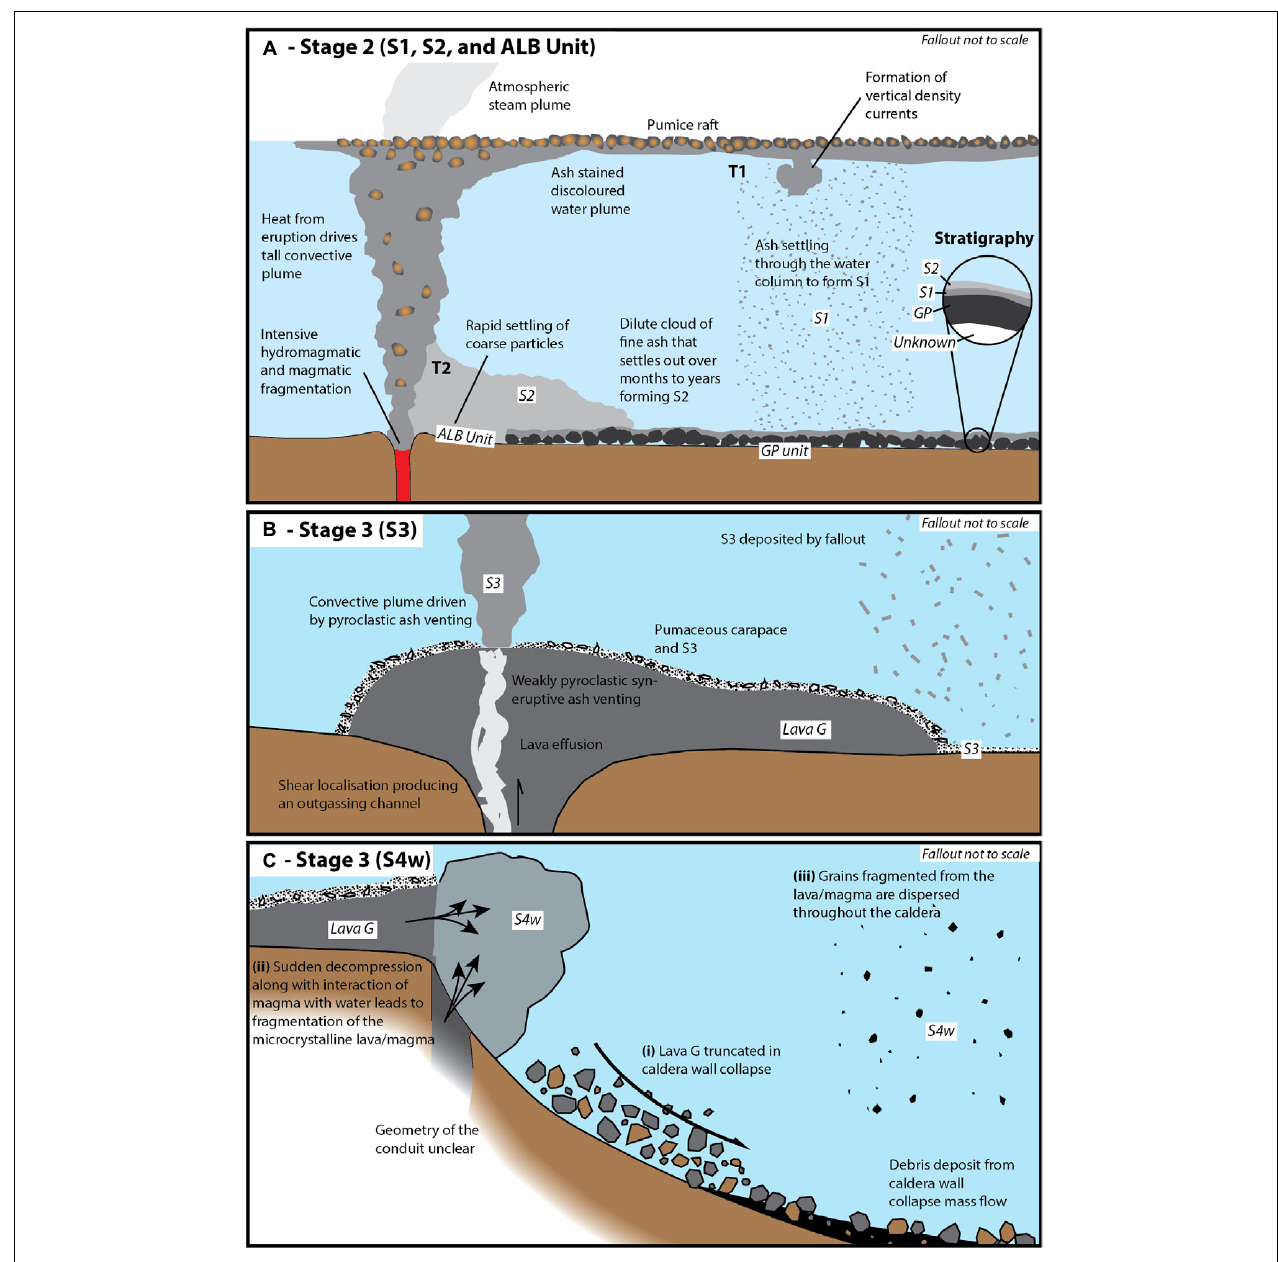
FIGURE 11 | Conceptual model for generation of the various subunits of the seafloor AL unit at Havre. (a) Subunits 1 and 2 are inferred to have been formed from the same eruption [at time 1 (T1) and time 2 (T2), respectively], along with the ALB unit and pumice raft. Energetic wet and dry fragmentation of a highly undercooled, ascending, vesiculating magma generated abundant fine particles that were dispersed in an overlying convective column, fallout from which formed S1. Partial or whole-scale collapse of the column, possibility due to vent widening, lead to the formation of density currents. Rapid deposition of the coarse fraction produced the ALB unit surrounding the vent. The remaining dilute flow was then dispersed widely, and from it S2 was deposited. (b) Subunit 3 formed during weakly pyroclastic ash venting during the eruption of Lava G. Far-reaching dispersal of the ash occurred in a weak convective column overlying the source of the pyroclastic activity. (c) Subunit 4w is inferred to have been formed following caldera wall collapse. Exposure of the hot microcrystalline core of Lava G (+H and I?) to the ambient water resulted in fine-scale fragmentation and dispersal.